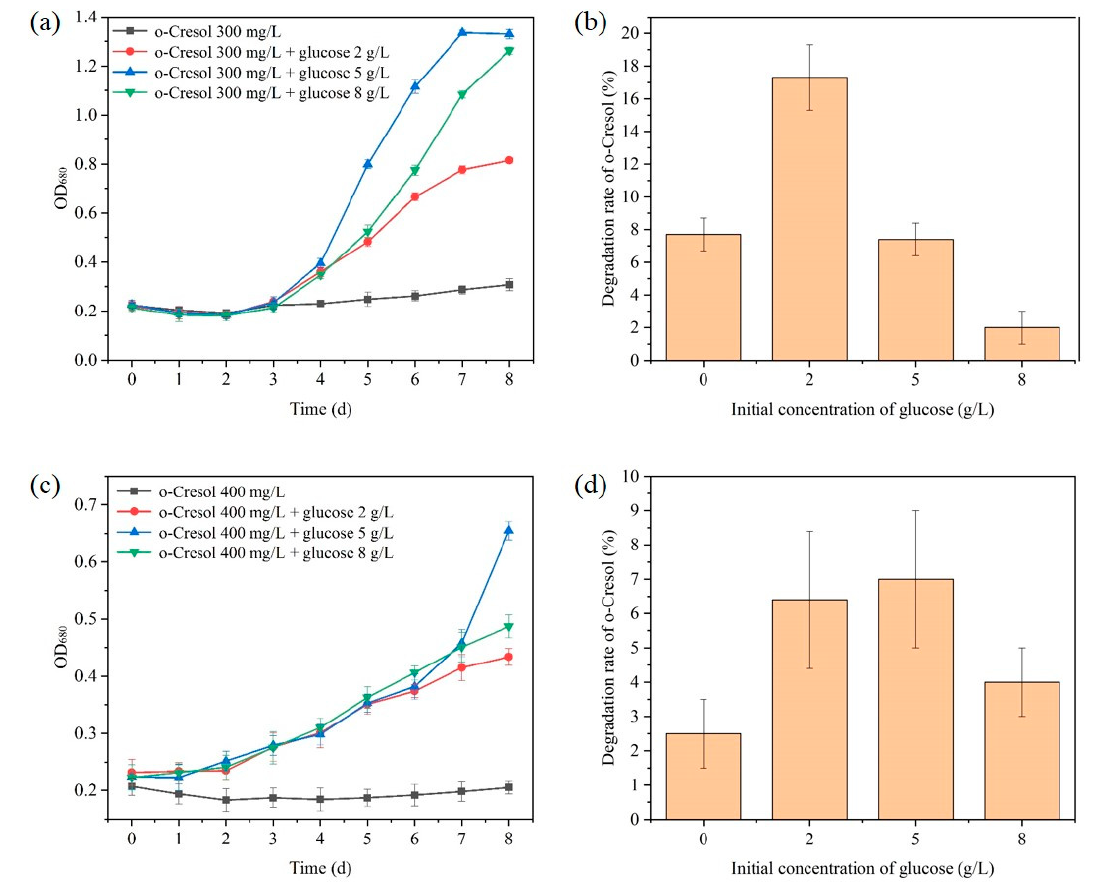
Figure 4. Co-degradation of glucose and o-cresol. ( a , c ) growth curve in the co-degrading system; ( b , d ) o-cresol degradation rate.